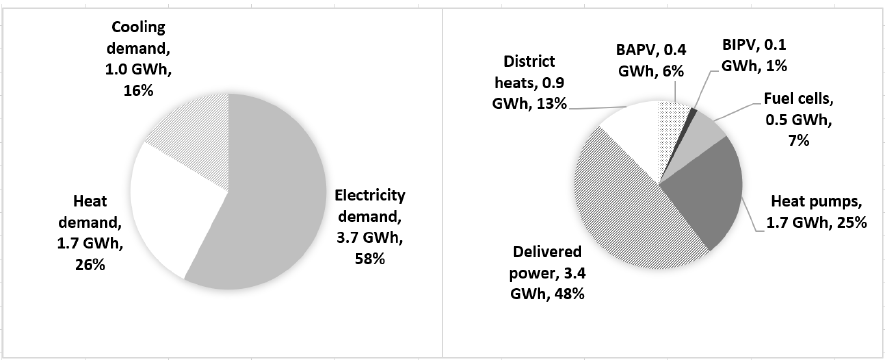
Figure 1. The energy supply and demands in Case 1.